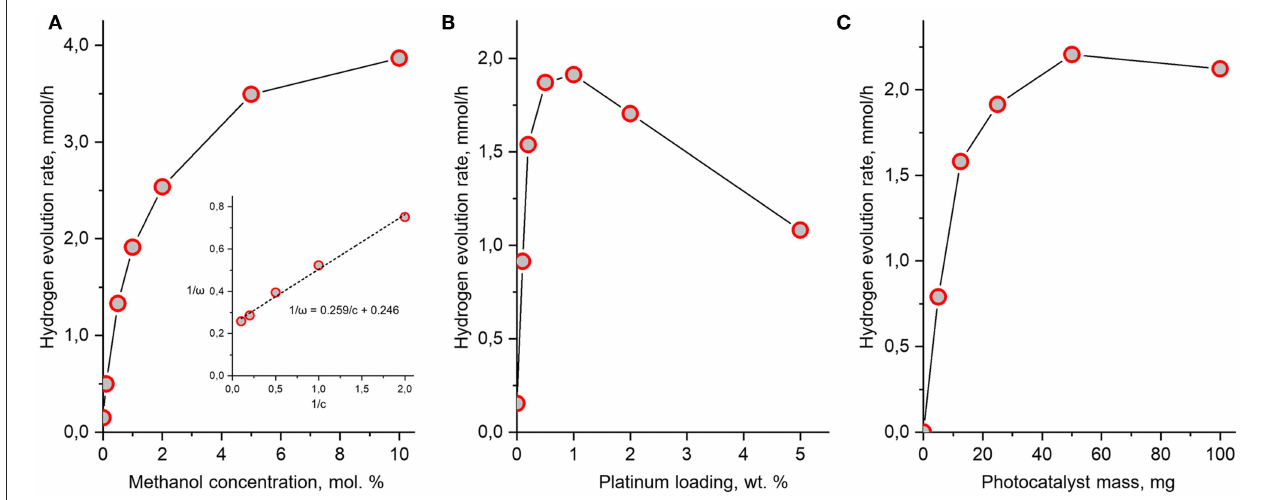
FIGURE 10 | Dependence of hydrogen evolution rate over H 2 Nd 2 Ti 3 O 10 × BuNH 2 /Pt on methanol concentration (A) , platinum loading (B) , and photocatalyst mass (C) . Unless varied, the methanol concentration is 1mol.%, the platinum content is 1 wt.% and the mass of photocatalyst is 25mg in every